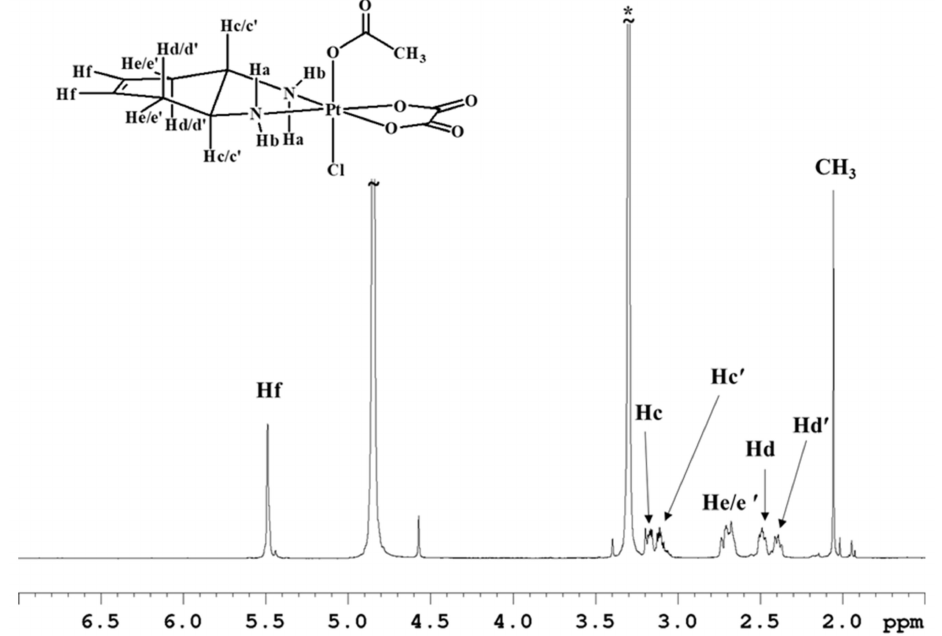
Figure 4. 1 H-NMR (700 MHz, 1 H) spectrum of 5 in CD 3 OD. * indicates residual solvent